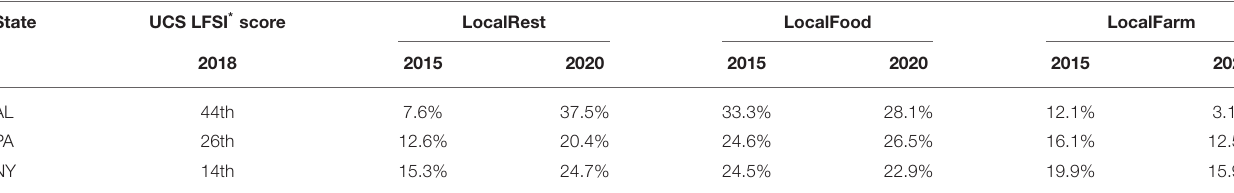
TABLE 2 | Results of local restaurant/food/farm tweets out of all local tweets within the state. State UCS LFSI *